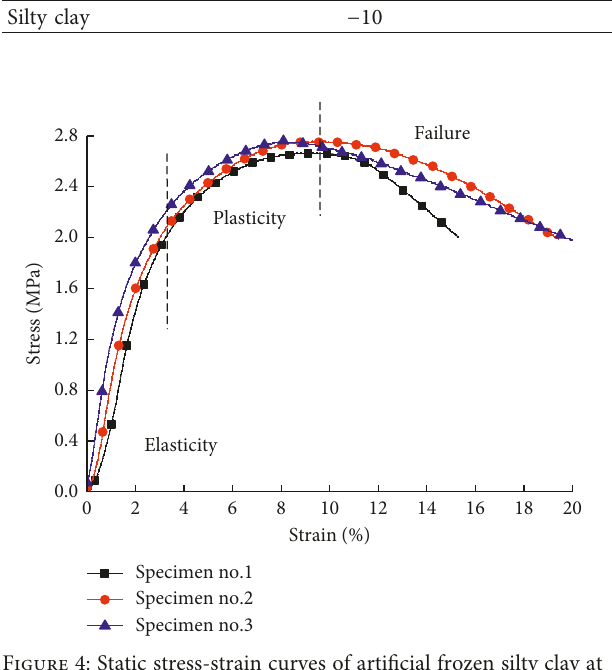
Figure 4: Static stress-strain curves of artificial frozen silty clay at − 10 ° C.